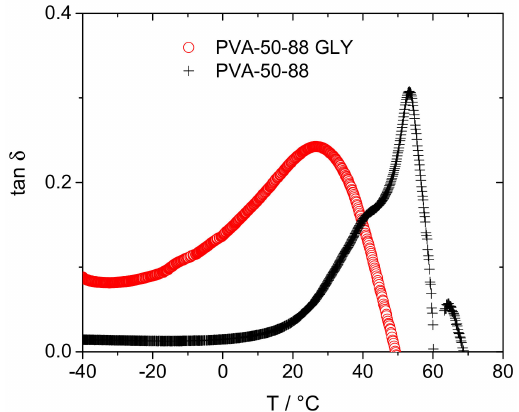
Figure 4. DMA data for pure air-dried PVA-50-88 (black) and air-dried glycerol-plasticized PVA-50-88 (red) following equilibration in air at 33% relative